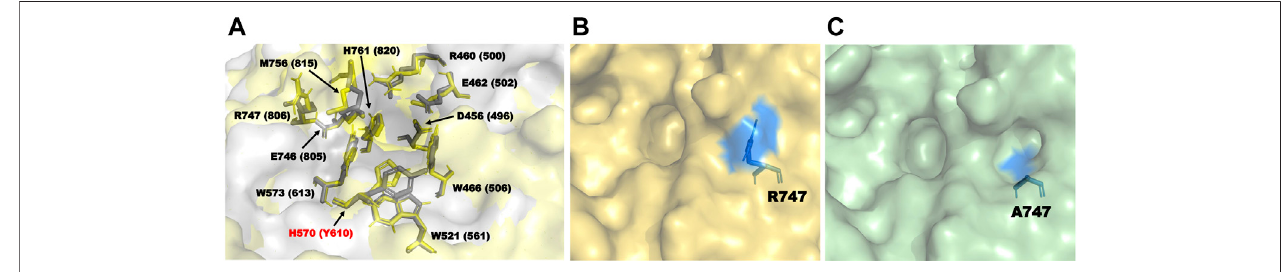
FIGURE 6 | The key residues in the TpeRha model and DtRha model. (A) Superimposition of active sites of TpeRha built in this study and DtRha from D. thermophilum . Residues are respectively colored in yellow and gray. Numbers indicate the residue from TpeRha and the corresponding residues from DtRha. The con fl ict residue is H570 of TpeRha and Y610 of DtRha. (B) The location and status of residue R747 in TpeRha. (C) The location and status of residue A747 in TpeRha.